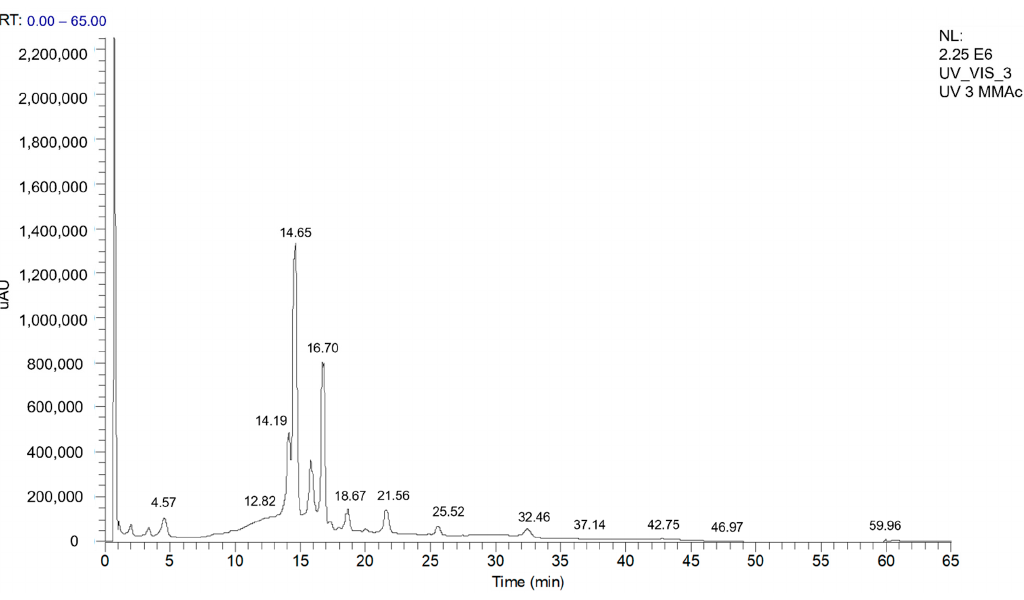
Figure 1. UHPLC-DAD-ESI-MS/MS chromatogram profile for MMEAF monitored at 254 nm.